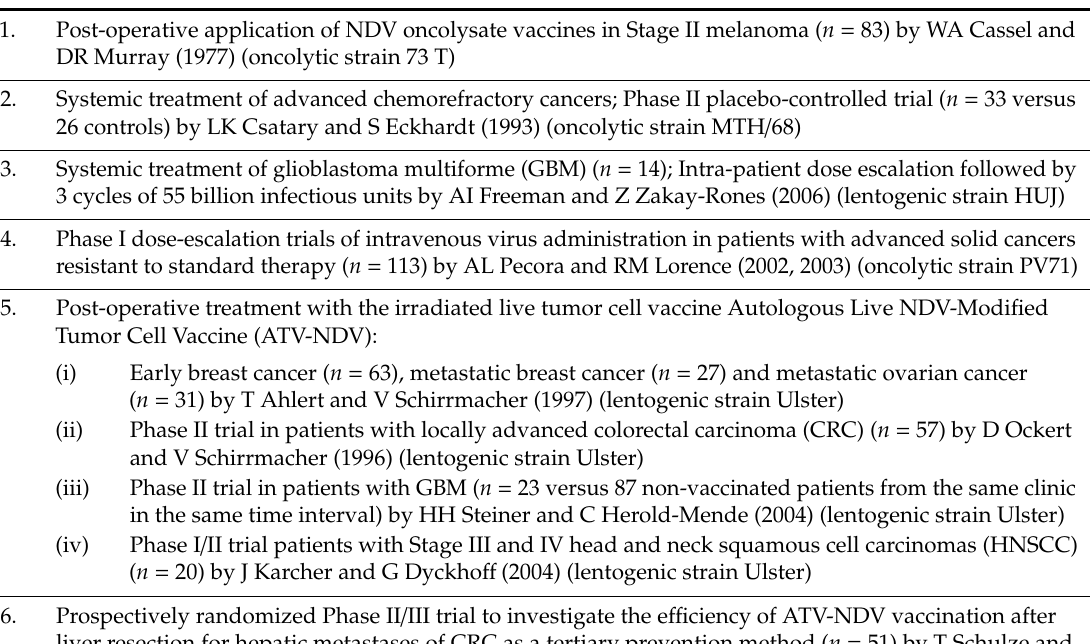
Table 3. Clinical application of NDV (Part